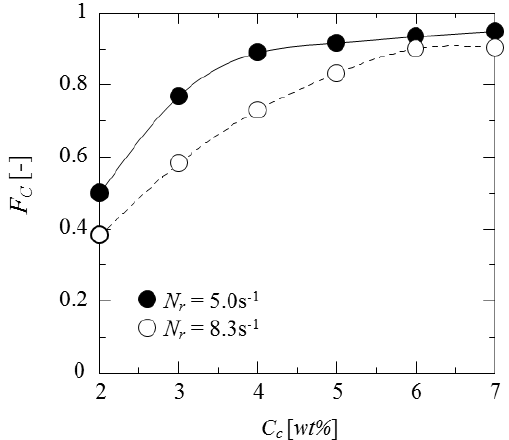
Figure 11. Dependence of content of core material on curdlan